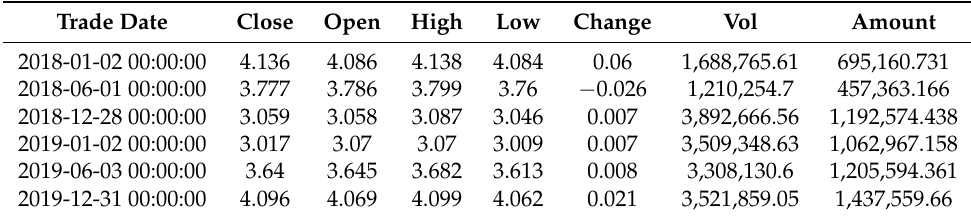
Table 1. Some basic data of CSI 300 Index